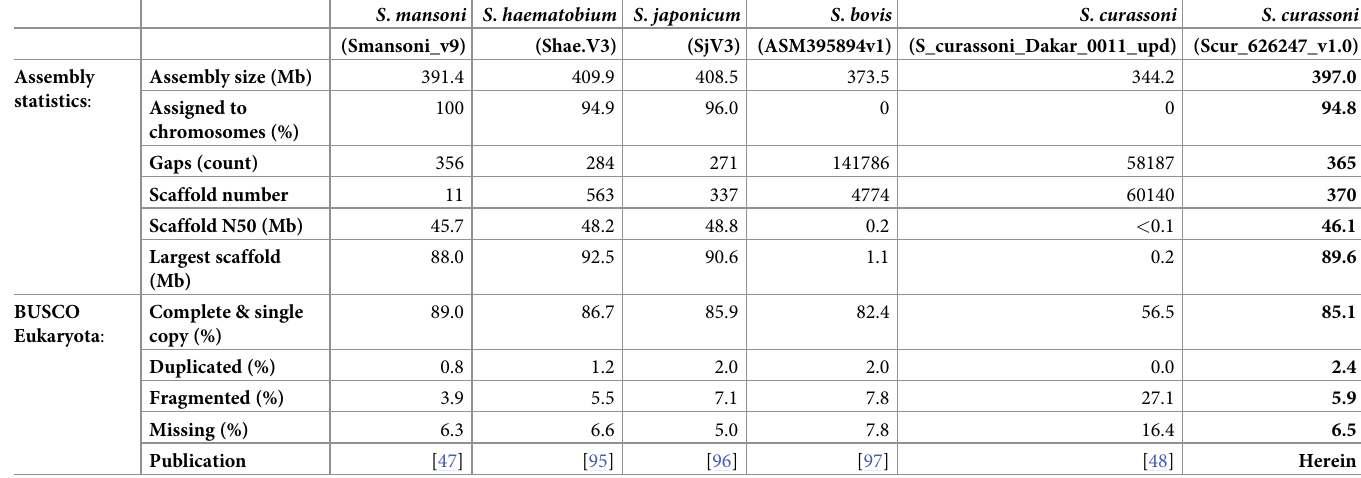
Table 1. Genome assembly summary statistics. We assessed the completeness of the curated assembly by searching for conserved, single copy genes using BUSCO (Benchmarking Universal Single-Copy Orthologs) and the eukaryota lineage (odb10)